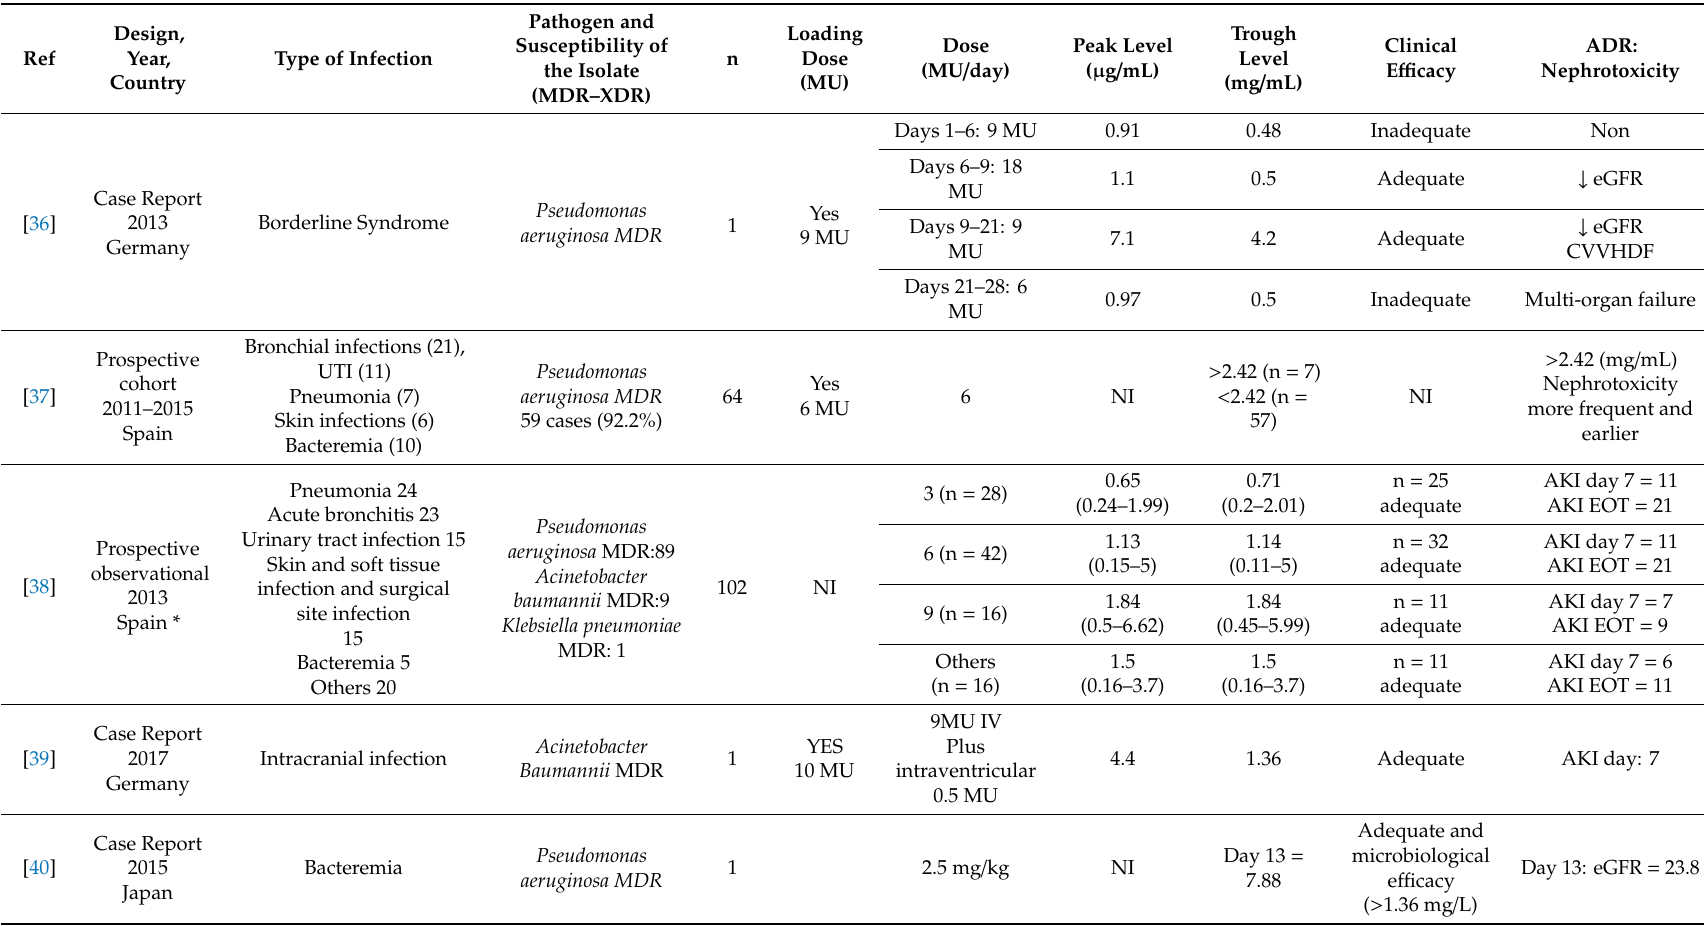
Table 1. The main characteristics of the studies